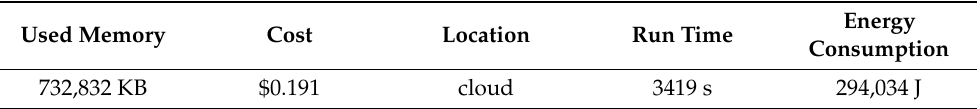
Table 18. Task ID 334016 specifications.